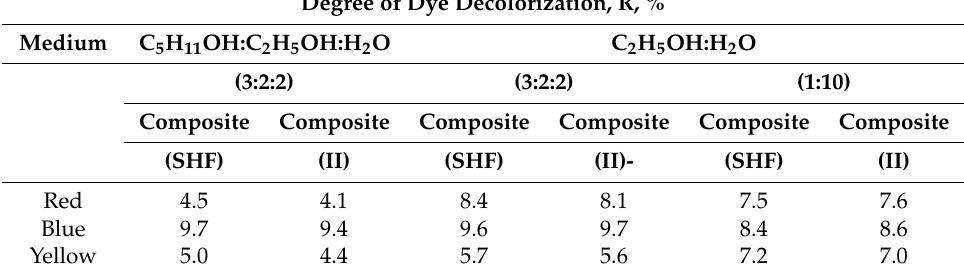
Table 4. Degree of extraction (R, %) of fat-soluble dyes (red, blue, Sudan yellow) with participation of composites from water-organic media. The determination error is 3–5%. Contact time is 6 h.